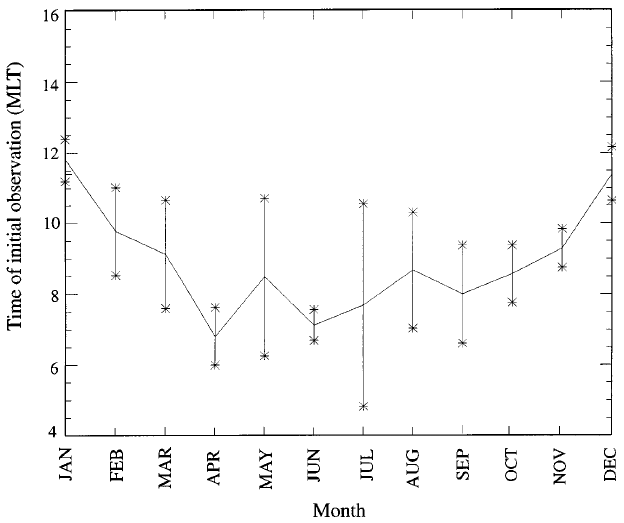
Fig. 7. Average time of initial observation of PIF signatures, for the subset of events observed by the CUTLASS Finland radar when run in a normal scan mode. The observations were made between March 1995 and February